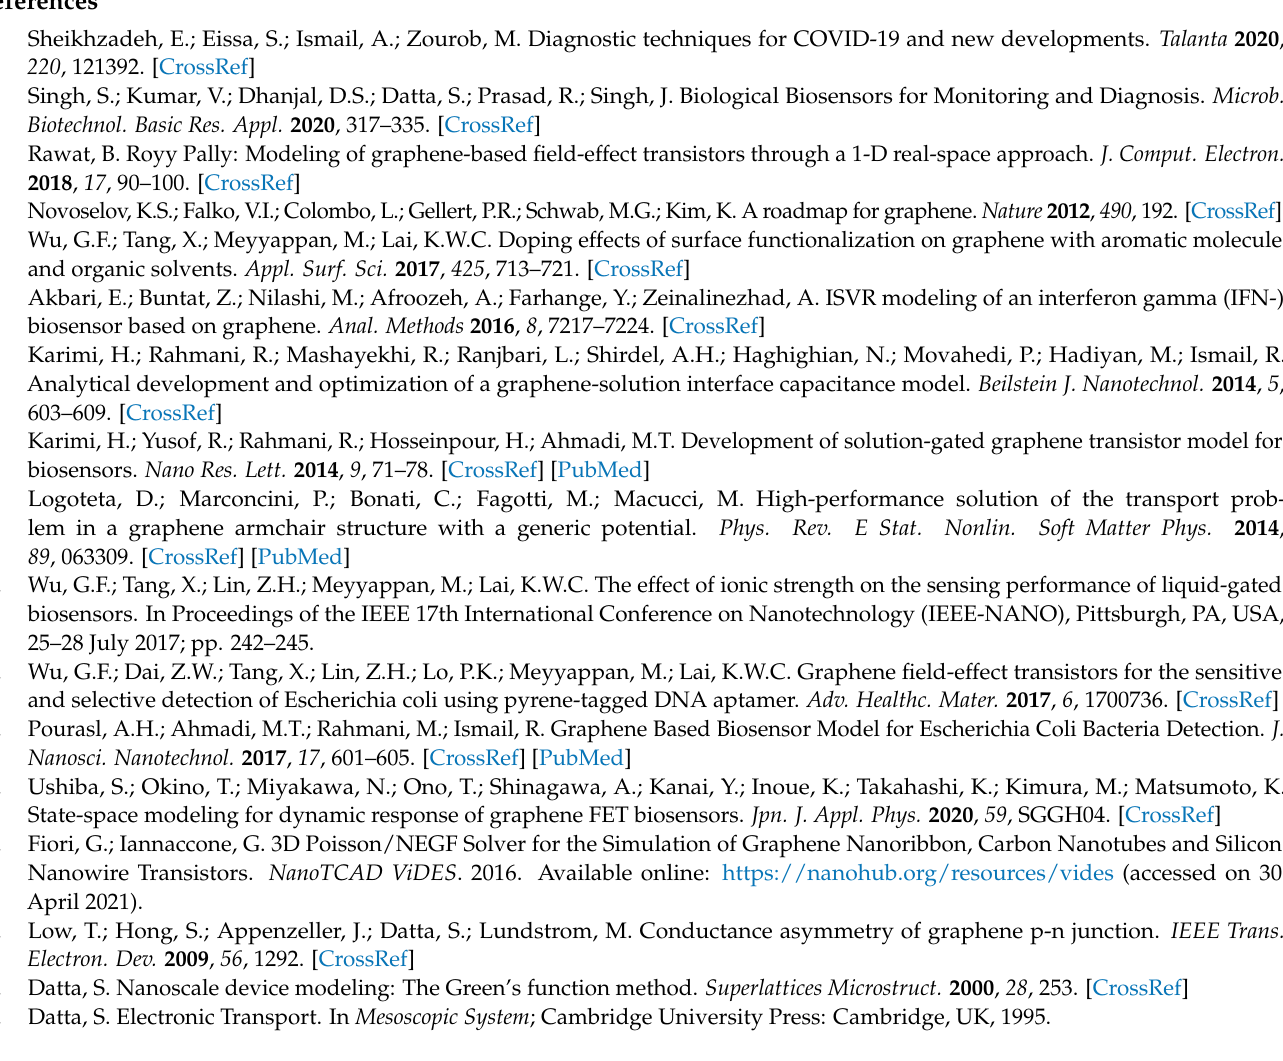
Figure A5. Energy dispersion with 3 nearest neighbors. ( a ) Three nearest neighbors (3N-N); ( b ) band energy comparison for N-N; ( c ) 3N-N.